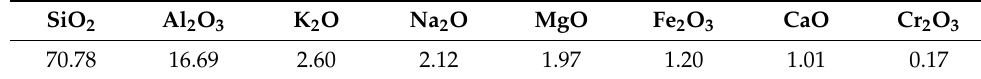
Table 4. Chemical composition of soil used (in %).